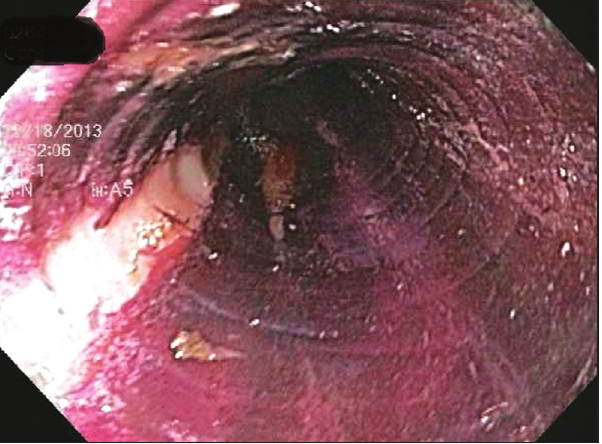
Figure 2) Violacaeous esophageal epithelium that instantly desquamated on contact with the flexible